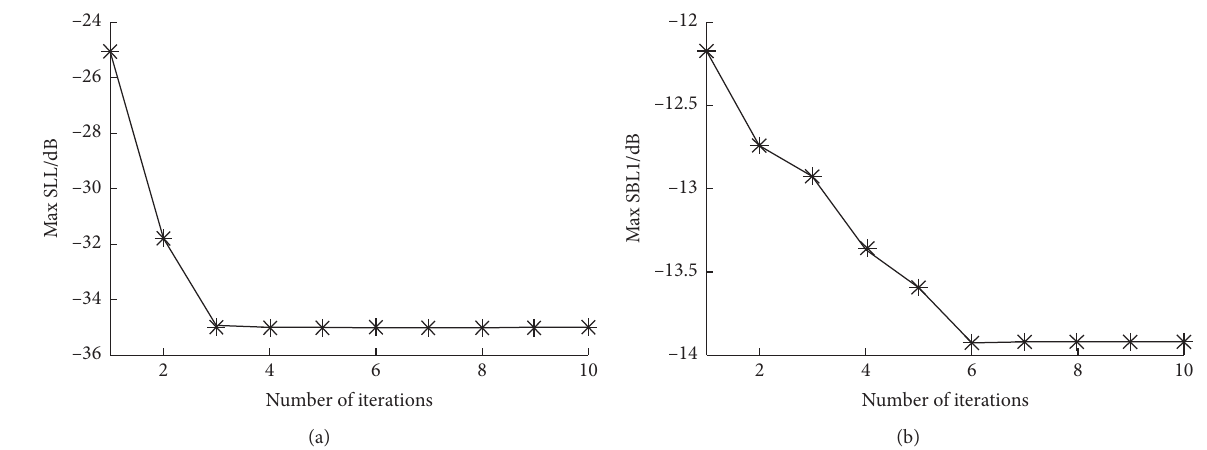
Figure 8: Convergence curve of two stages: (a) the first stage and (b) the second stage.